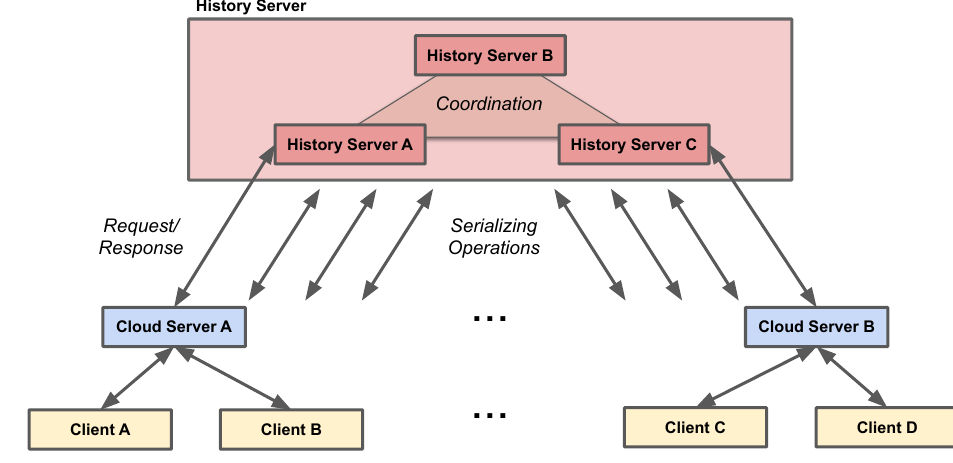
Figure 2. A History Server using Strong